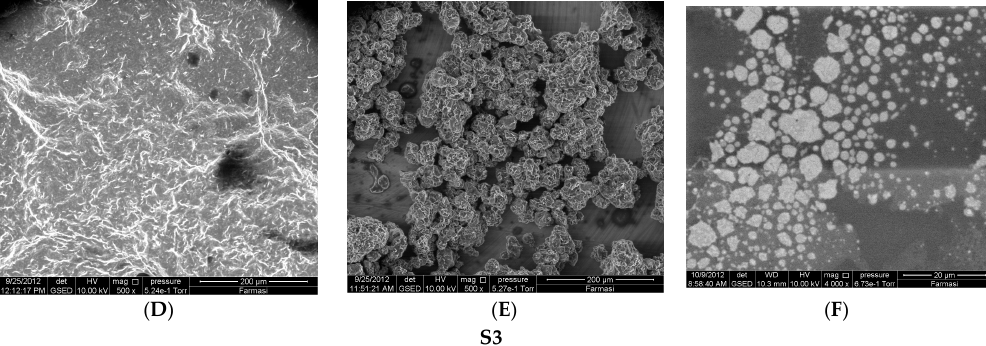
Figure 2. Environmental Scanning Electron Microscope (eSEM) images for the proniosome formulations S1 ( A – C ); S3 ( D – F ) without hydration, less hydration (2 mL), and more hydration (5 mL), respectively.